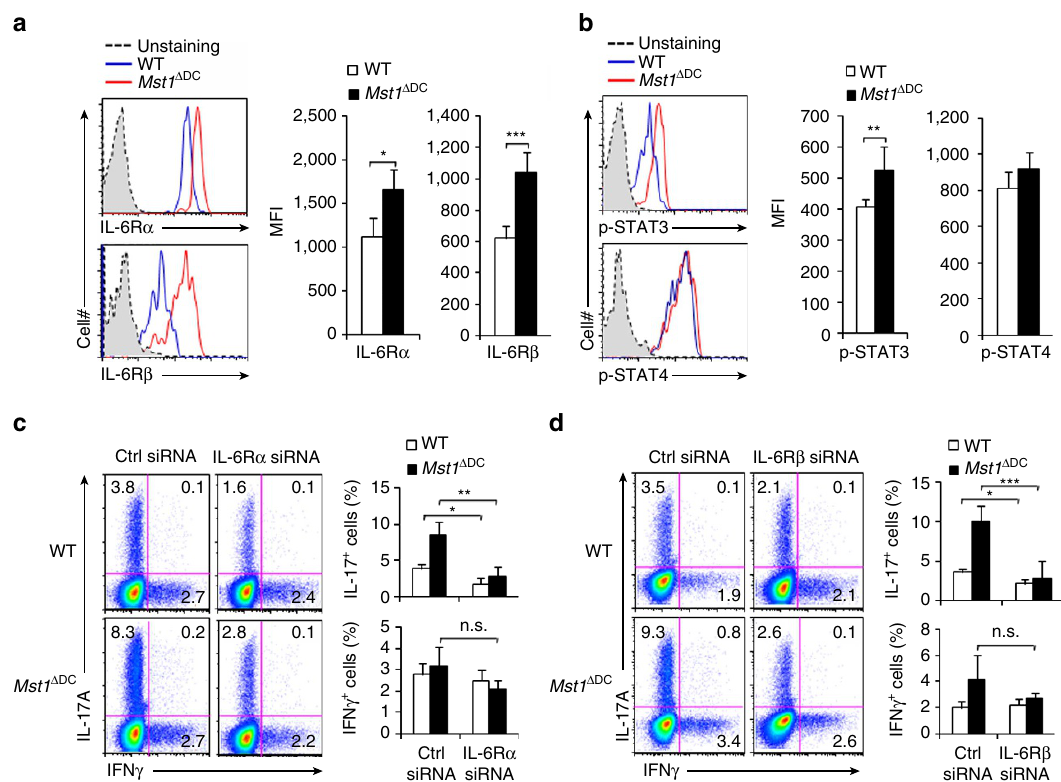
Figure 7 | T-cell IL-6R-p-STAT3 is responsible for DC MST1 signalling. ( a ) Expression of IL-6R a and IL-6R b (gp130) in T cells co-cultured with WT or Mst1 D DC splenic DCs for 3 days. Right, the mean fluorescent intensity (MFI) is summarized. ( b ) Intercellular staining of p-STAT3 and p-STAT4 in T cells co-cultured with WTor Mst1 D DC splenic DCs for 3 days. Right, MFI of the indicated protein is summarized. ( c , d ) Sorted CD4 þ Tcells were transfected with control or IL-6R a ( c ) and IL-6R b ( d ) siRNA vector and stimulated with WTor Mst1 D DC splenic DCs for 5 days. The intercellular staining of IL-17 and IFN g in T cells performed with FCM and a typical figure shown. Right, the proportion of IL-17 and IFN g in T cells. Data are representative of three to four independent experiments (mean ± s.d.; n ¼ 4). * P o 0.05, ** P o 0.01 and *** P o 0.001, compared with the indicated groups. n.s., not significant. P -values were determined using Student’s t